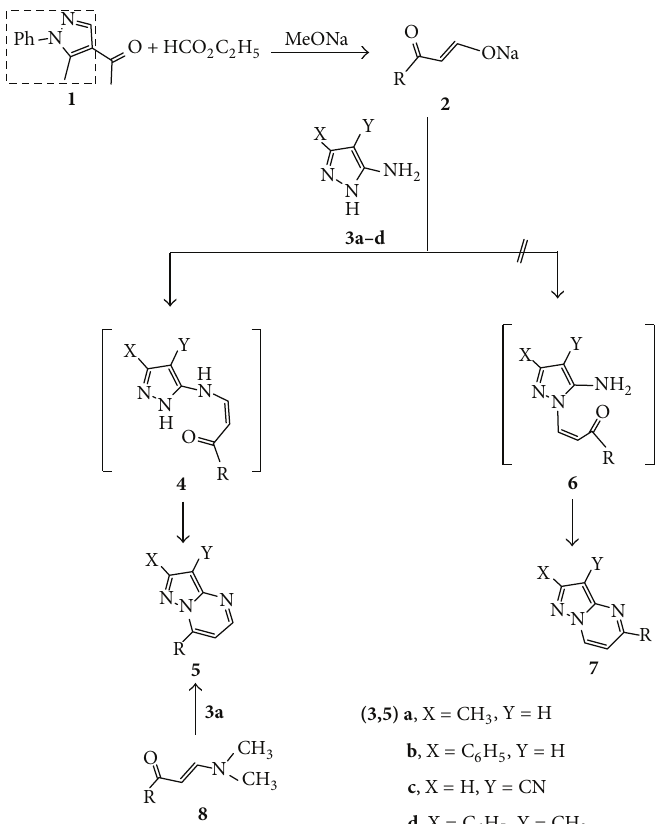
Scheme 1: Synthesis of pyrazolo[1,5- a ]pyrimidines (5a–d) . signals at 𝛿 = 2.61 (s, 3H, CH 3 ), 2.69 (s, 3H, CH 3 ), 6.36 (d, 1H, 𝐽 =